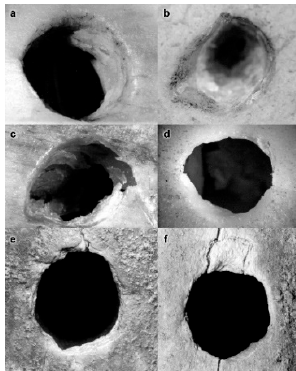
Figure 3. Experimental holes on juvenile femur diaphysis of brown bear made by: ( a ) a bear’s canine tooth, hole size 8.2 × 8.2 mm; ( b ) a hyena’s lower canine tooth, hole size 6.5 × 8.3 mm; ( c ) a hyena’s 3rd upper premolar, hole size 6.5 × 9.0 mm; ( d ) a hole made by a pointed stone tool and bone punch, size 6.0 × 7.4 mm ( e, f ) complete holes no. 2 (size 8.2 × 9.7 mm) and 3 (size 8.7 × 9.0 mm) on the femur from DB no. 652 (ZRC SAZU, Archive of Institute of Archaeology).